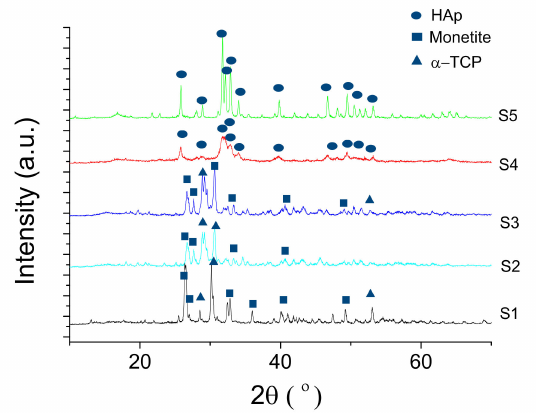
Figure 5. XRD patterns of CPC layers prepared by the pulse current with di ff erent